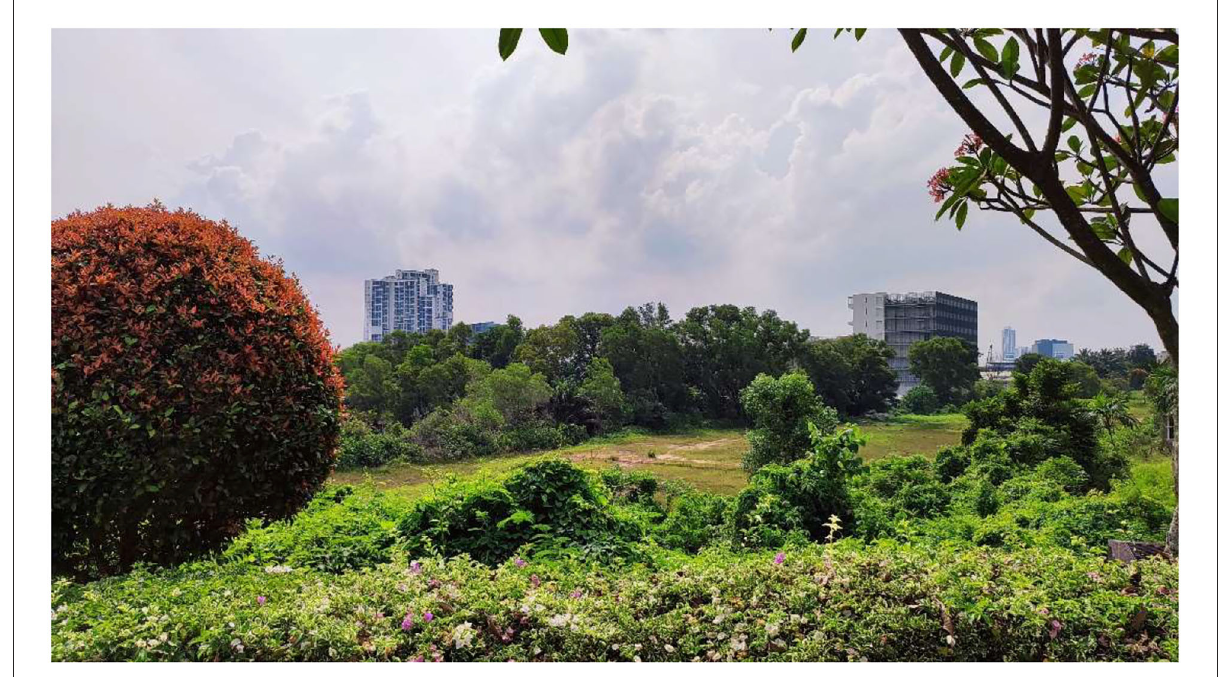
FIGURE6 A view from within Cyberjaya, a town with room for growth, Malaysia. Photo: P.